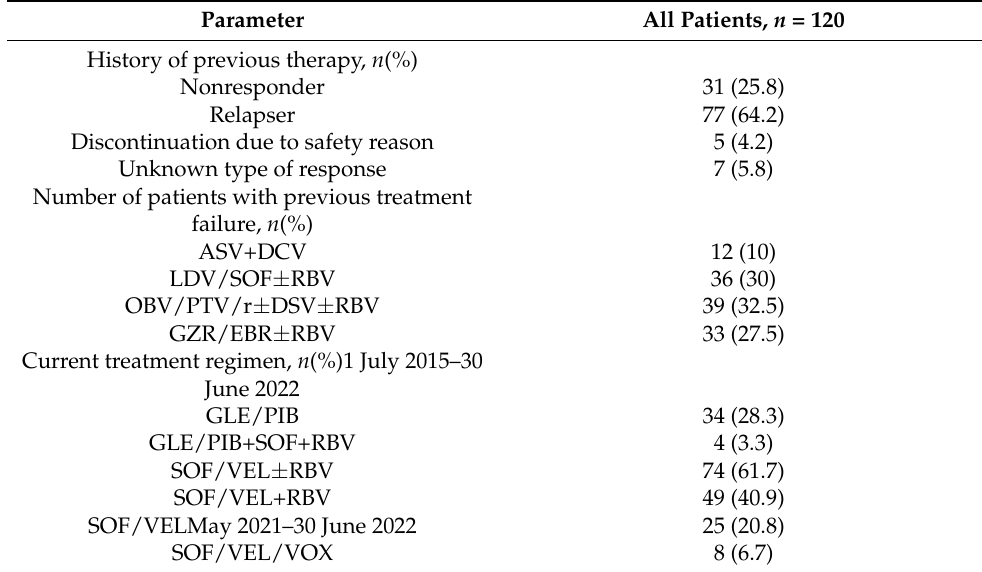
Table 4. Treatment